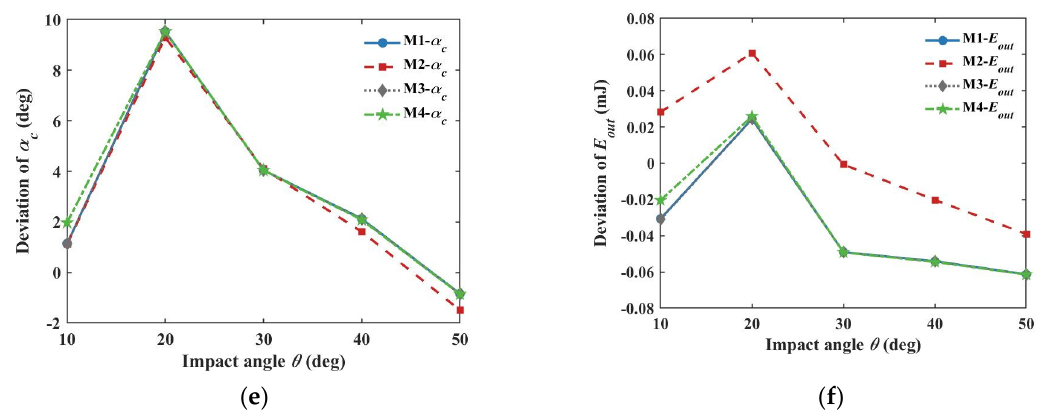
Figure 5. Deviation comparison between the four contact force models. ( a ) deviation of e n ; ( b ) devi- ation of e t ; ( c ) deviation of ω out ; ( d ) deviation of α v ; ( e ) deviation of α c ; ( f ) deviation of E out .